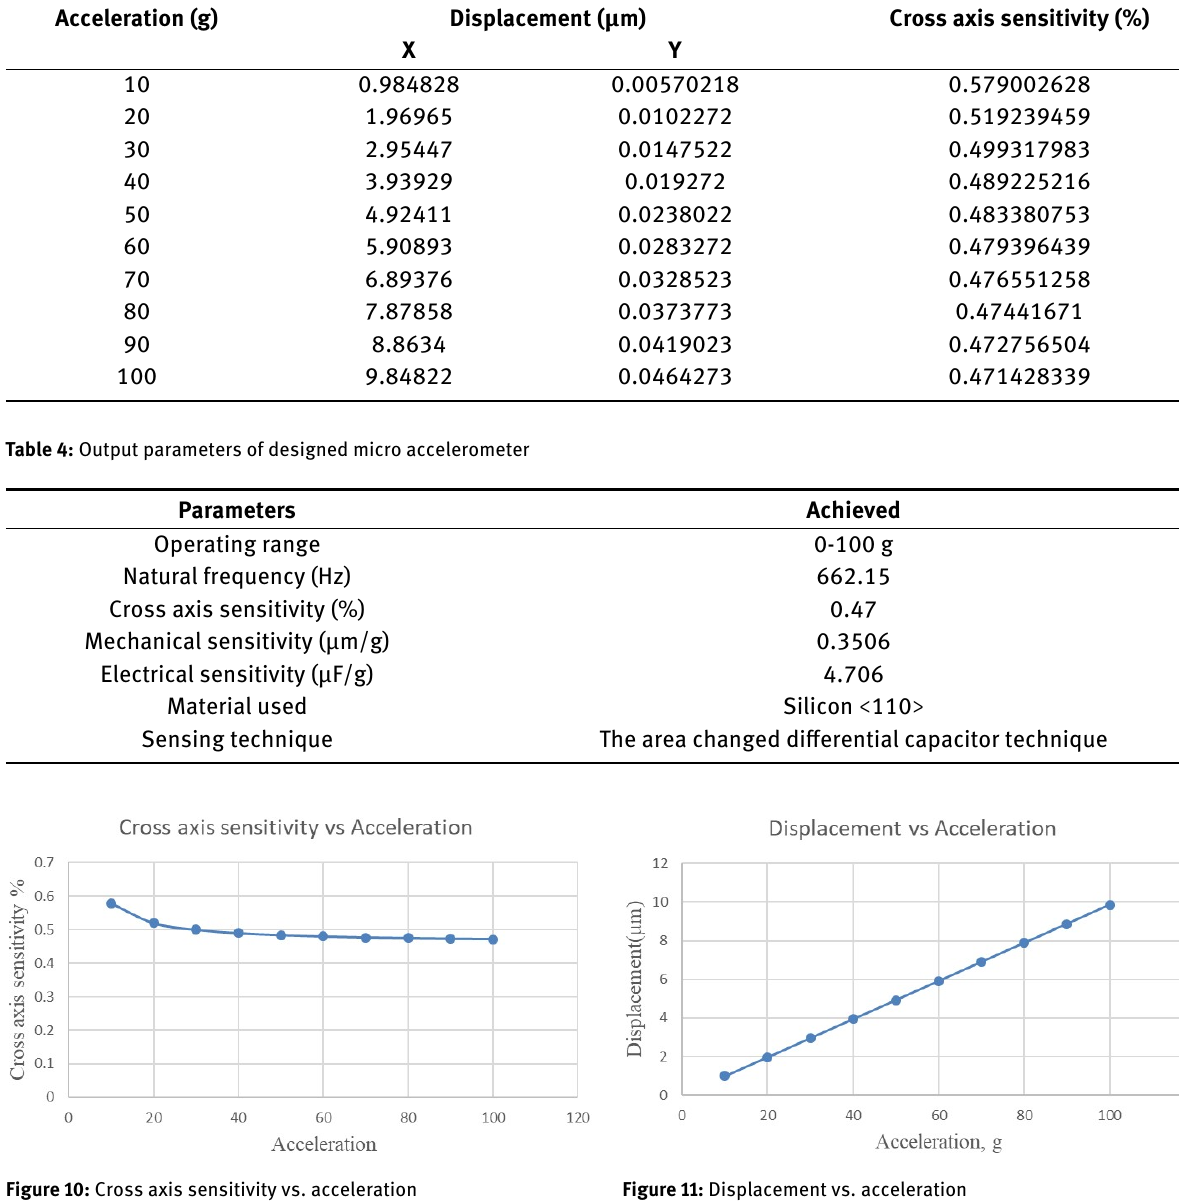
Table 3: Optimised design result